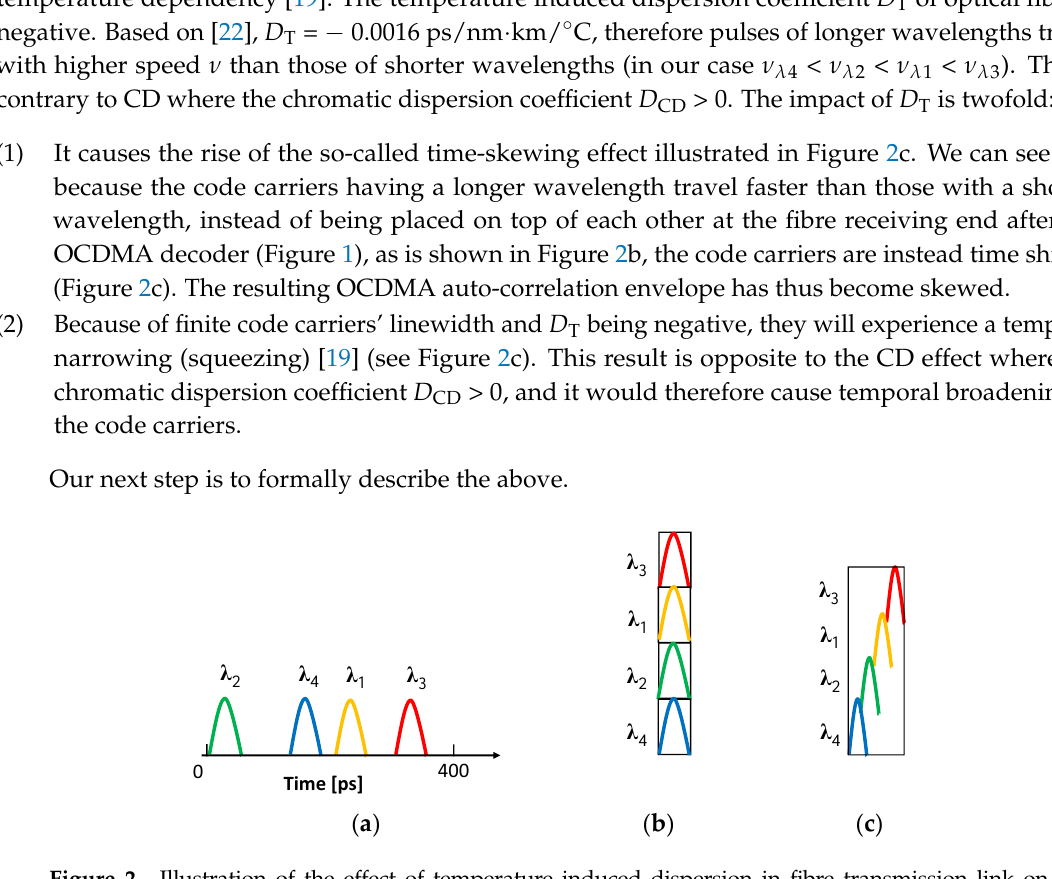
Figure 2. Illustration of the effect of temperature induced dispersion in fibre transmission link on incoherent optical code division multiple access (OCDMA). ( a ) Two-dimensional wavelength-hopping time-spreading (2D-WH/TS) transmitted OCDMA code; ( b ) Recovered OCDMA auto-correlation—ideal case; and, ( c ) Recovered OCDMA auto-correlation time-skewed and compressed due to the temperature induced dispersion effects ( D T < 0).